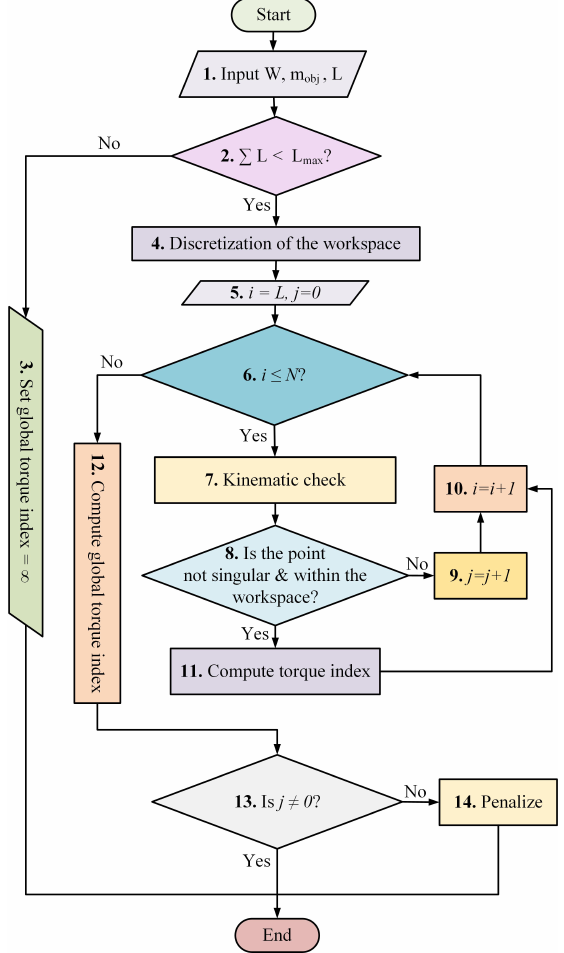
Figure 5. Flowchart of the algorithm used to compute the objective function within the